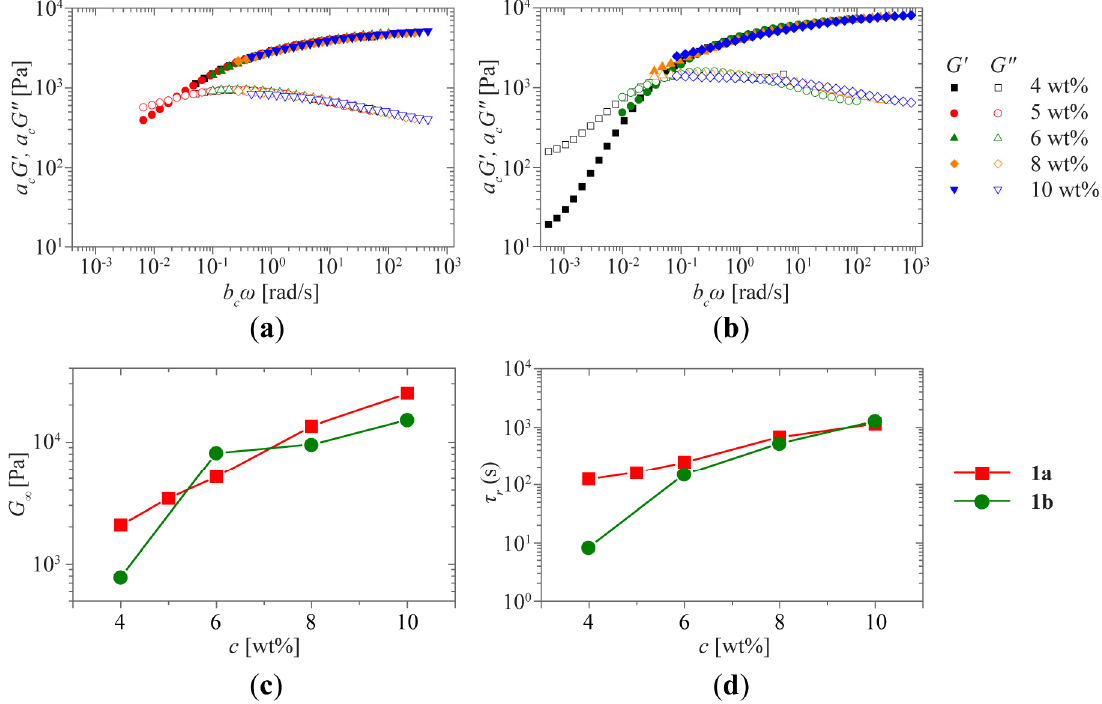
Figure 6. Time–Concentration Superposition. Rescaling of the original curves for 1a ( a ) and 1b ( b ) at concentrations ranging from 4 to 10 wt % was performed using and b for the moduli G ′ and G ″ and the frequency concentration-dependent shift factors a c c ω , respectively. These shift factors were used to determine the high frequency moduli G ( d ) for 1a (red squares) and 1b (green circles) as function of ( c ) and relaxation time τ r concentration c , using the 6 wt % curve as reference condition for both compounds. Connecting lines are added to guide the